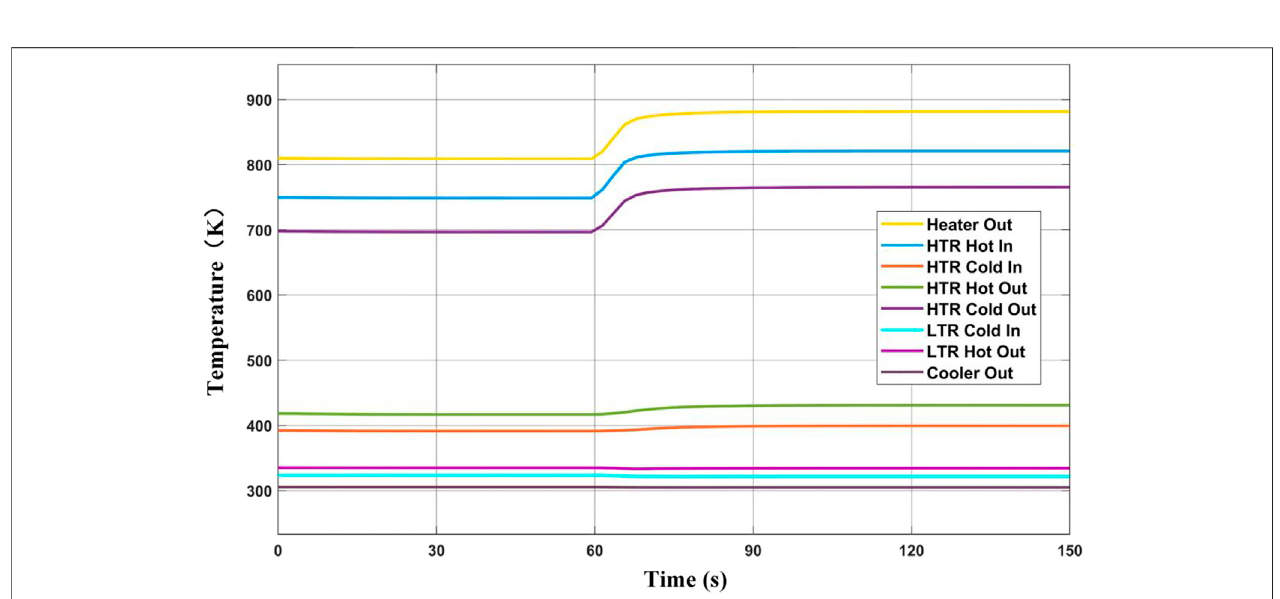
FIGURE 9 | Dynamic response of cycle temperature while reducing the cycle mass fl ow